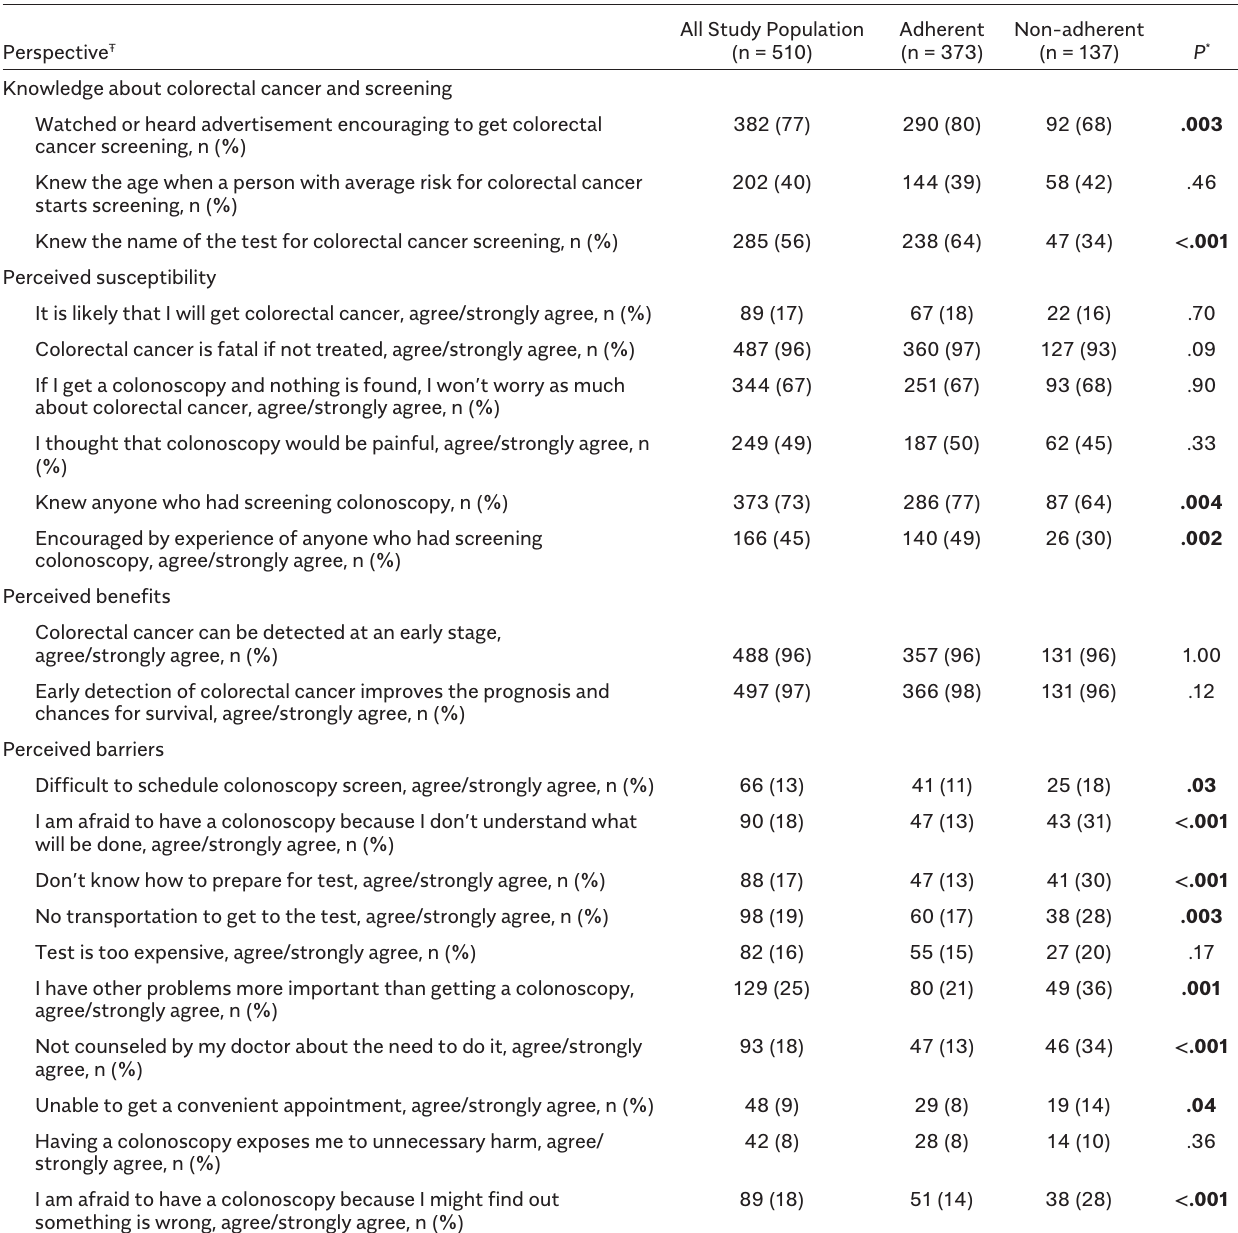
All Study Population Adherent Non-adherent (n = 510) (n = 373) (n = 137) P *